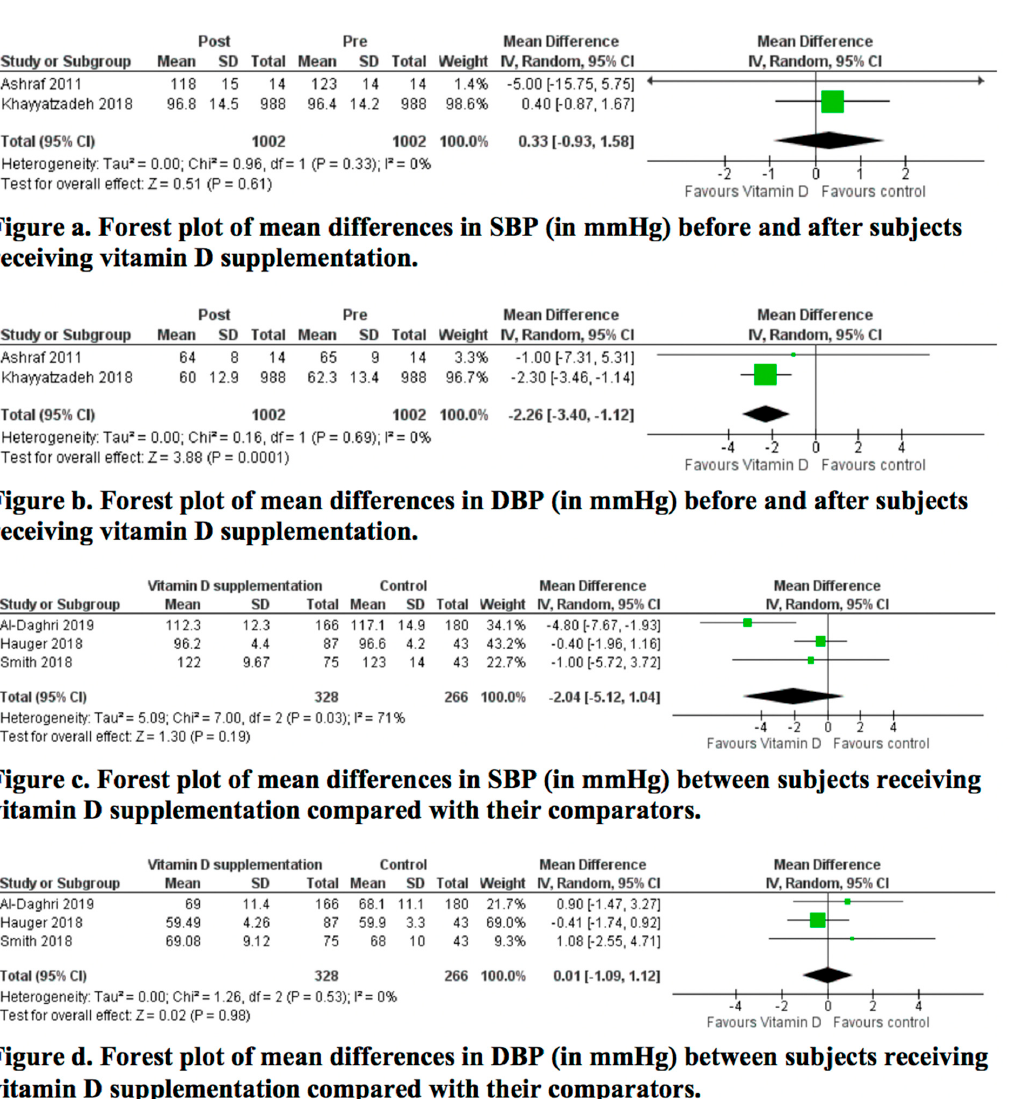
Figure 4. Meta-analysis of effects of vitamin D supplementation on SBP and DBP. Mean differences for each study are represented by squares, and 95% CIs are represented by the lines through the squares. The pooled mean differences are represented by diamonds. Between-study heterogeneity was assessed with the use of the I2 statistic. SBP: systolic blood pressure; DBP: diastolic blood pressure.